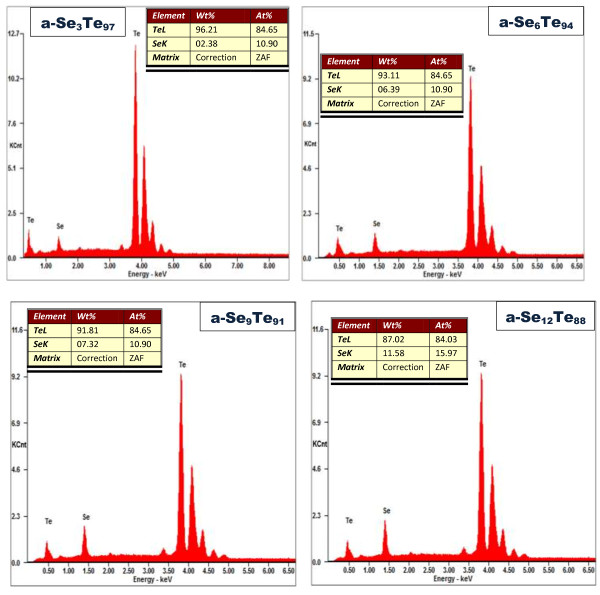
EDS spectra of a-Se

x

Te100-x thin films.